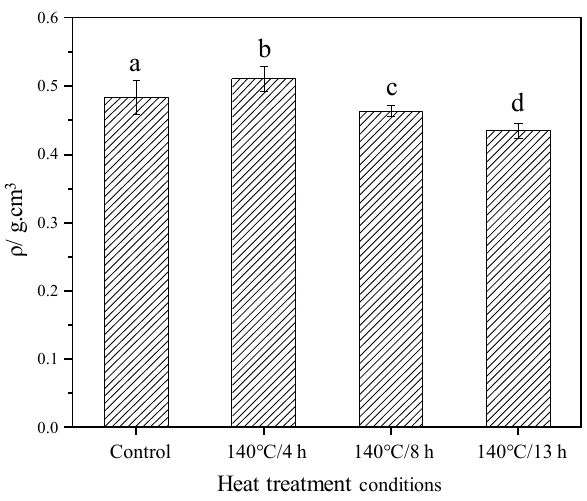
Figure 2. Absolute dry density of the control and modified wood. Bars with different letters (a, b, c and d) indicate significant differences ( p < 0.05) according to Duncan’s multiple range tests.